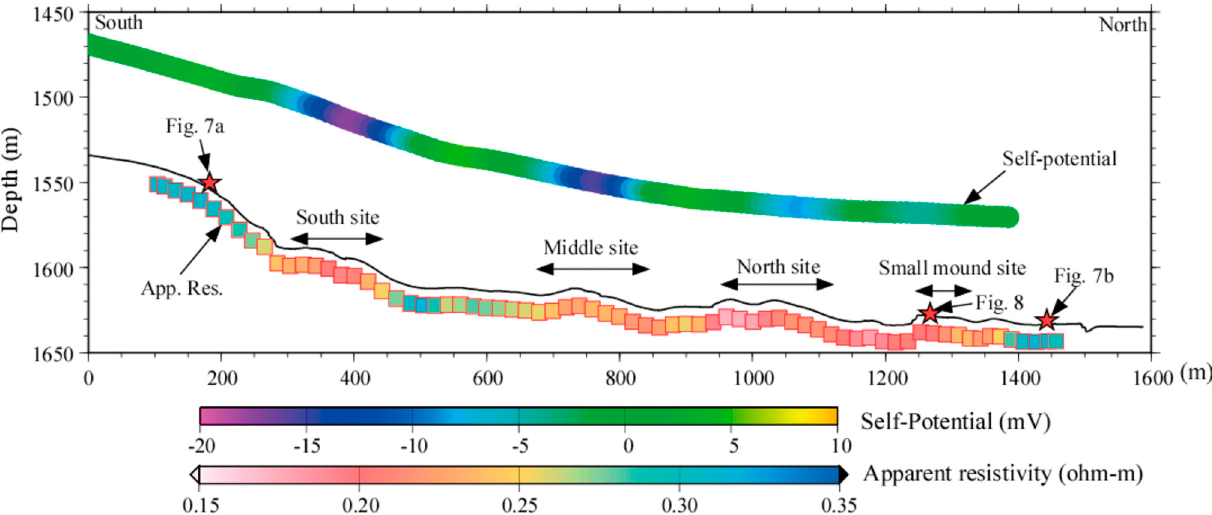
Figure 39. Apparent resistivities and integrated self ‐ potential data with bathymetry on the main survey line. The horizontal position of the calculated apparent resistivity is defined as the midpoint of the two AUVs (adapted from [116]).